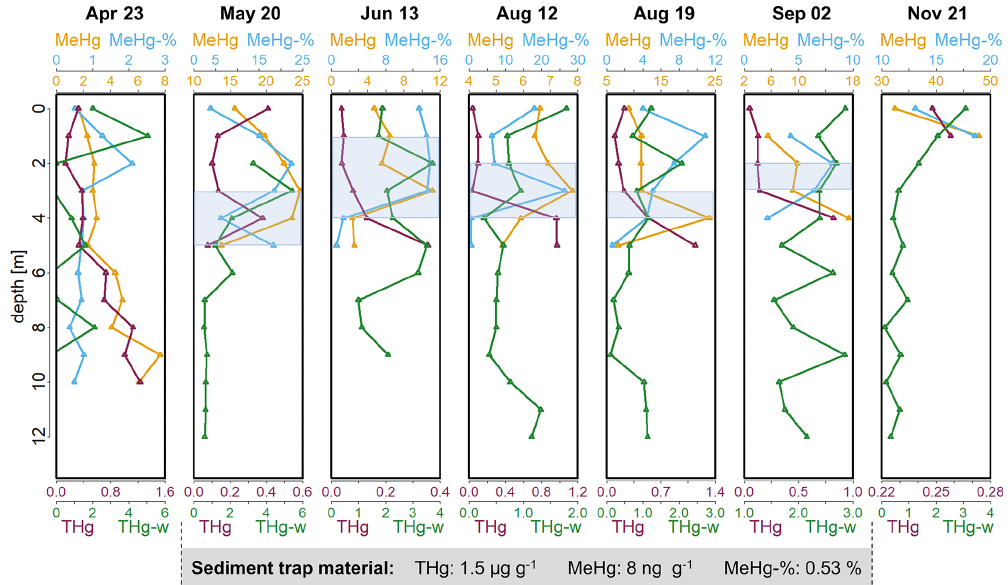
Figure 3. Depth profiles of MeHg (ngg − 1 ) concentrations, percentage of MeHg (%) of THg (MeHg-%), THg concentrations in seston (µgg − 1 ) and dissolved THg (ngL − 1 ) in the water column (THg-w) of Lake Ölper from April to November 2019. The depth of the sharp decrease in O 2 concentration and the start of Mn reduction (RTZ) are shown in each panel (shaded light blue). Concentrations of THg (µgg − 1 ), MeHg(ngg − 1 ) and MeHg-% (%) of the sediment trap material collected over the 141d between 6 May and 24 September are given in the gray box below. Note that each column has an individual scale to better illustrate changes with depth. Depth profiles with the same scale in all columns are shown in the Supplement (Fig. S5).